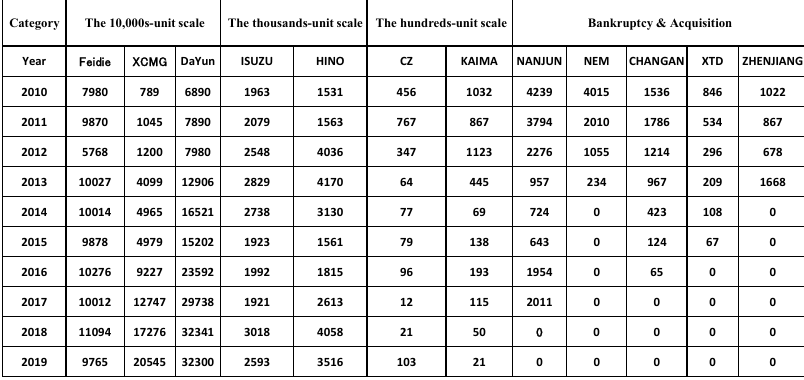
Source: China Automotive Technology and Research Center